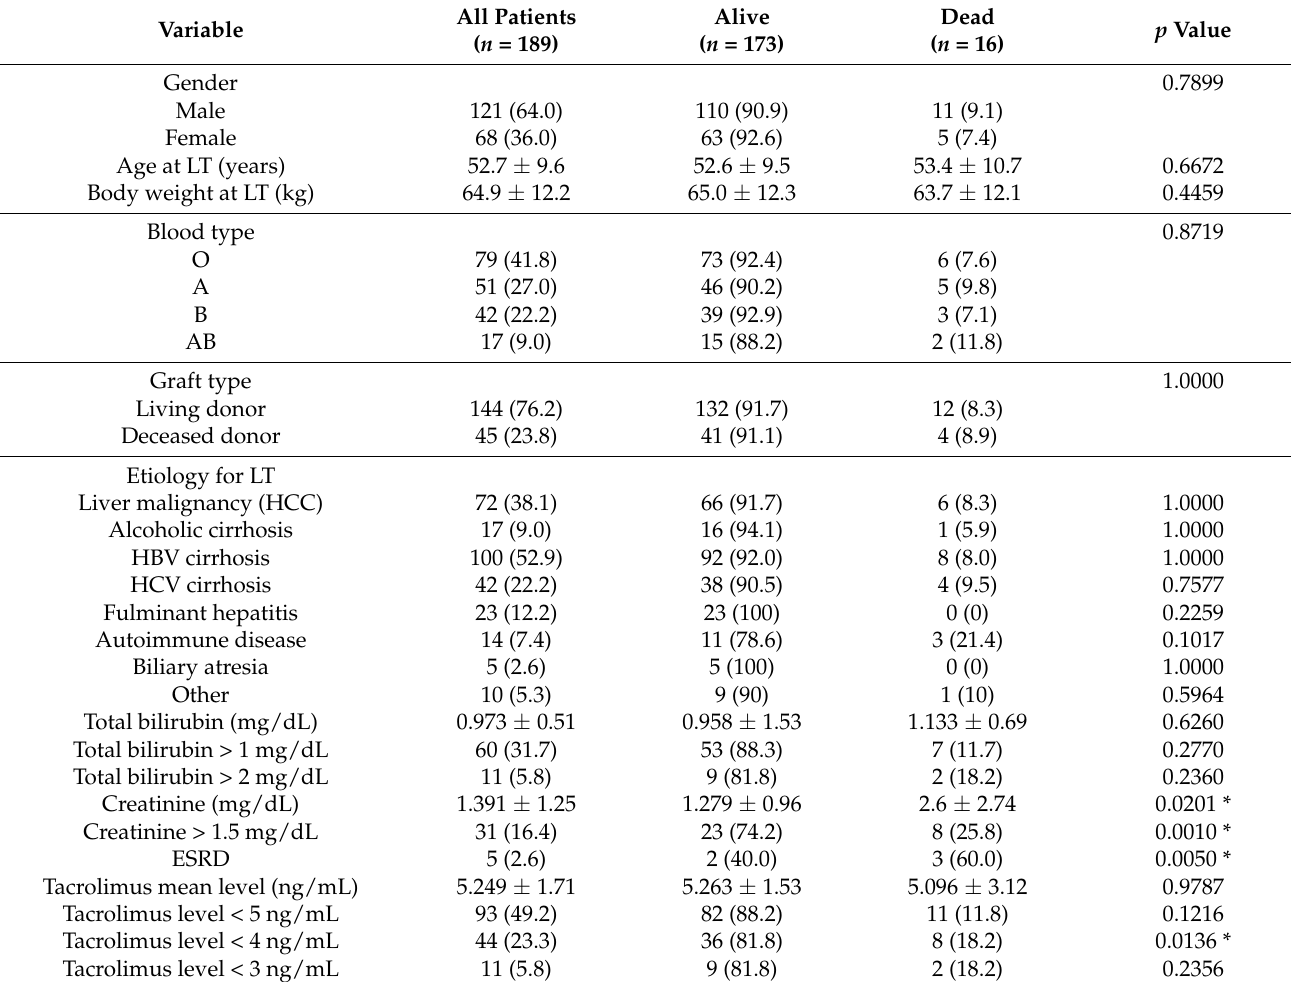
Table 1. Univariate analysis for comparing the distributions of the demographic and clinical characteristics between the alive and dead adult liver recipients after five years of liver